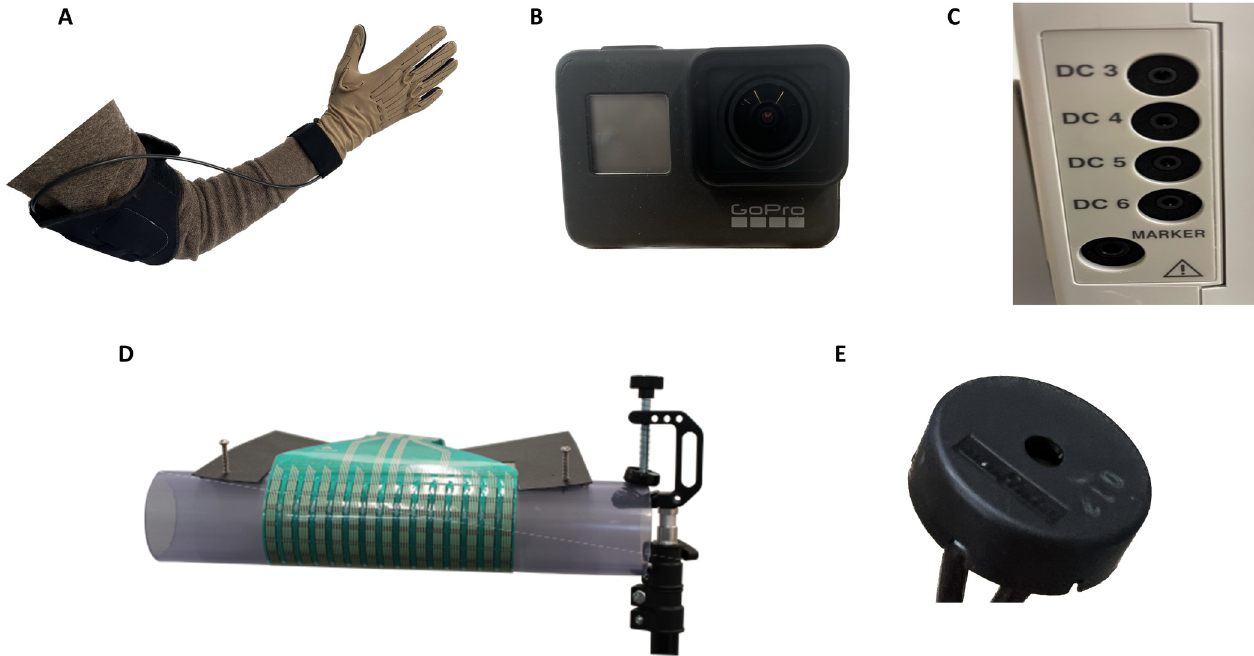
Fig 1. Intraoperative hand kinematics and kinetic recording devices. (A) CyberGlove III uses strain gauges and patient-specific calibrations to provide angle measurements for 23 different joints at 90 Hz. (B) A stock GoPro Hero 7 Black is used to record patient hand movements, and a custom GoPro Hero 7 Black with 8.25mm (47mm) f/2.8 lens for recording the surgical/stimulation site. (C) Nihon Kohden EEG-1200AA series is used clinically to monitor for seizure activity via ECoG grids near stimulation areas and allows for the input of parallel DC channels for other devices. (D) TekScan F-Socket pressure mat affixed to a 2.5 in diameter PVC pipe provides force recordings of hand grips at 200 Hz from force sensors at a density of 0.7 sensors/cm 2 . (E) Piezoelectric sensor outputs voltage differences across its terminals recorded by a Nihon Kohden DC channel in response to loud sounds such as the Go/Stimulate tone.